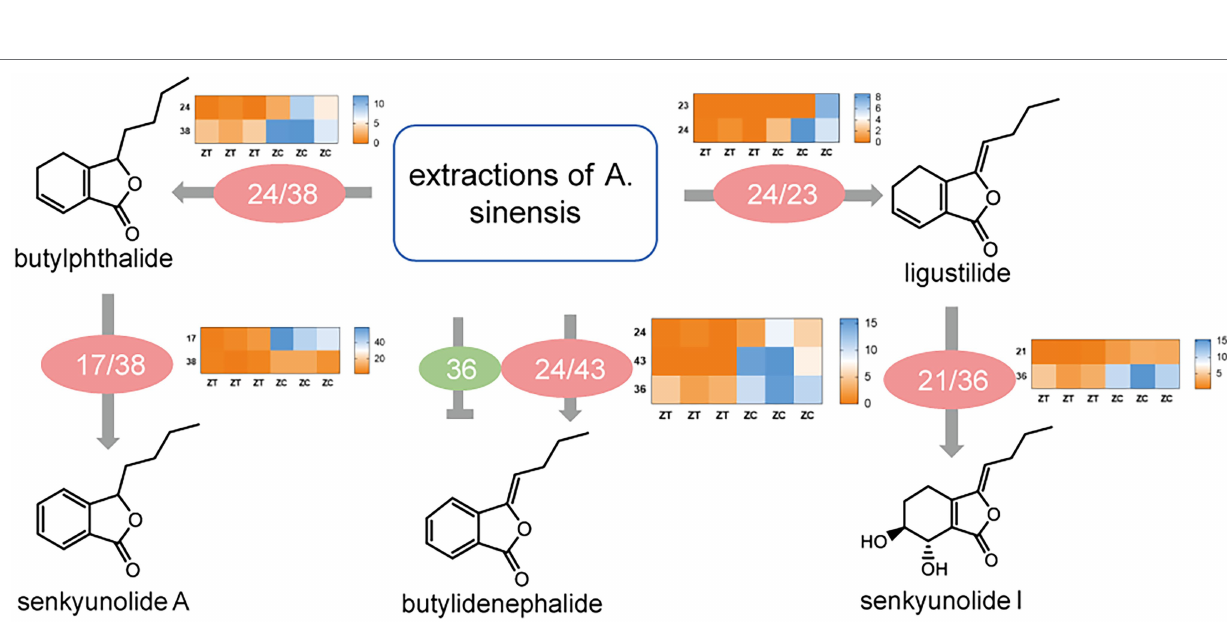
FIGURE 5 | Schematic model of the function of key candidate isoforms in phthalide accumulation and transformation and heatmap of the differential expression of genes involved in phthalide accumulation in ZT and ZC samples. ZC, root samples from normal flowering plant; ZT, root samples from early flowering